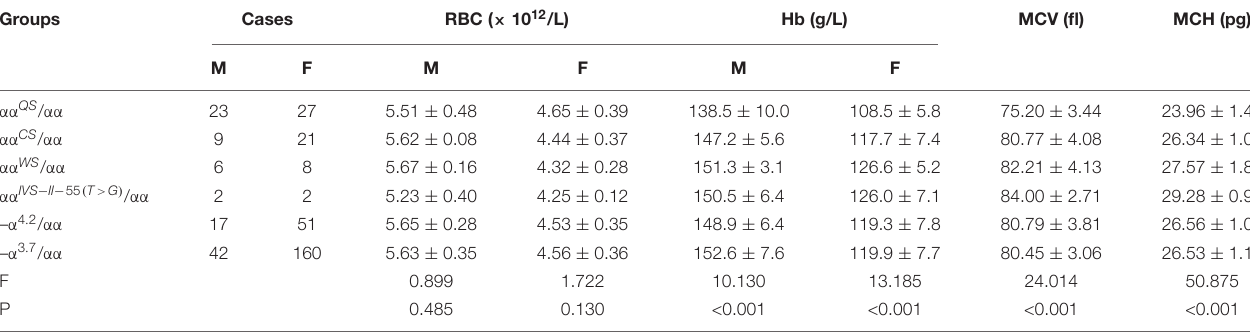
TABLE 2 | Comparison of hematological parameters among α -thalassemia silent carriers. Groups